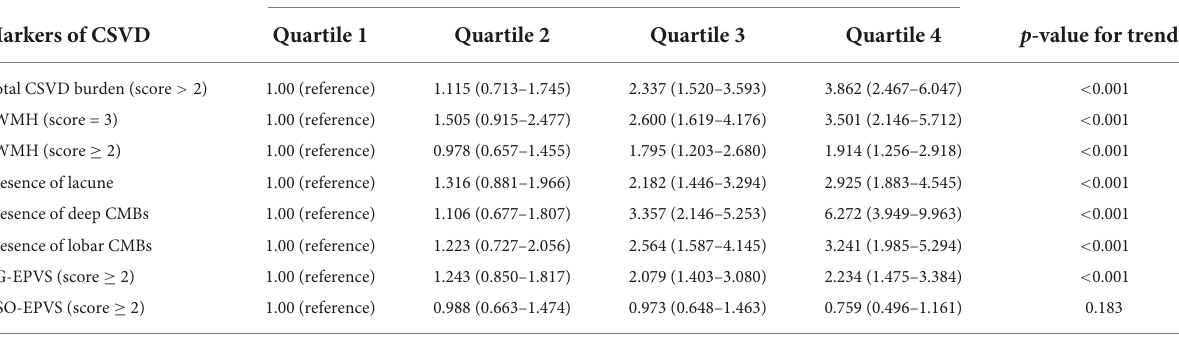
Serum tHcy levels a